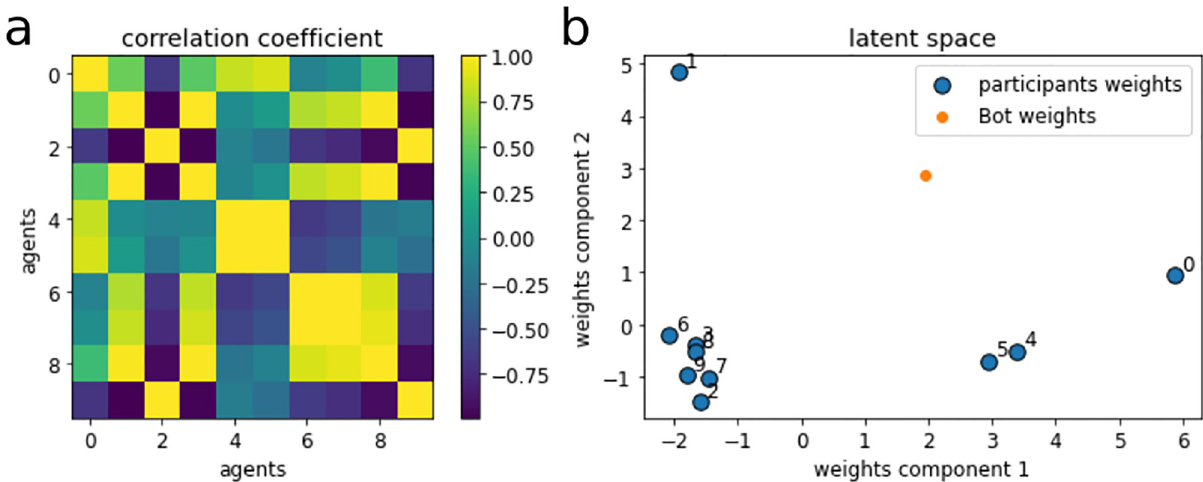
Fig 3. Example of a latent space of a variational autoencoder model trained on one of the teams in the study. (a) Correlation coefficient of the weights to the output layer of the variational autoencoder, after training. The clear structure of the data, as learned by the model, is seen in the clusters of high correlation coefficients. (b) The weights to the output layer projected on a 2-dimensional surface using principal component analysis. Three distinct clusters can be seen in the figure, each corresponding to a team of participants with similar response patterns. The model learned distinct representations corresponding to one large cluster (majority opinion) and two smaller clusters (minority opinions) as shown by the clear separation of the model’s weights in latent space. The bot player is represented in orange and shows a response pattern closer to the smaller clusters (minority opinions) than to the larger cluster (majority